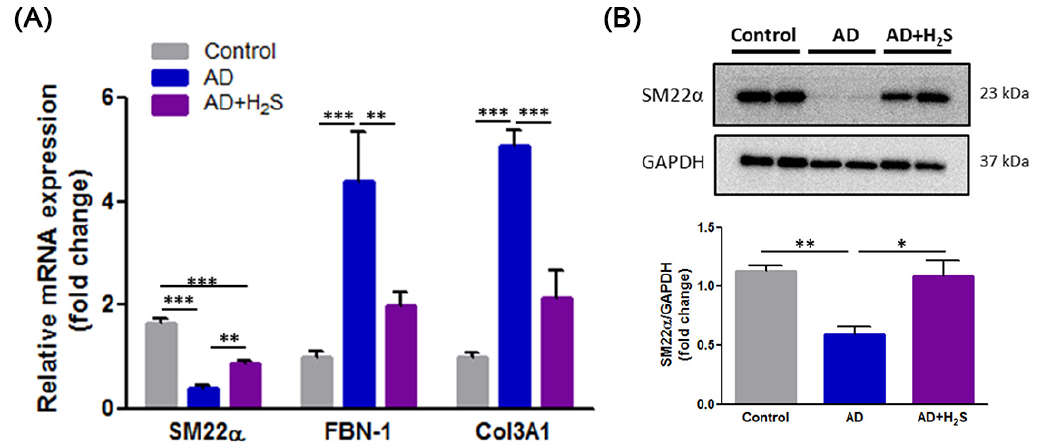
Figure 4. Protective effect of H 2 S maintains VSMC contractile phenotype. ( A ) The expression of SM22 α , FBN-1, and Col3A1 mRNA were examined using RT-qPCR in the aorta of each treatment group ( n = 5 per group). The data are expressed as mean ± SD. Statistical significance: ** p < 0.01, *** p < 0.001. ( B ) Western blot analysis of SM22 α expression in aortic tissue extracts from different groups of mice. GAPDH was used as a loading control. Quantification of protein levels are presented as means ± SD. Statistical significance: * p < 0.05, ** p < 0.01.